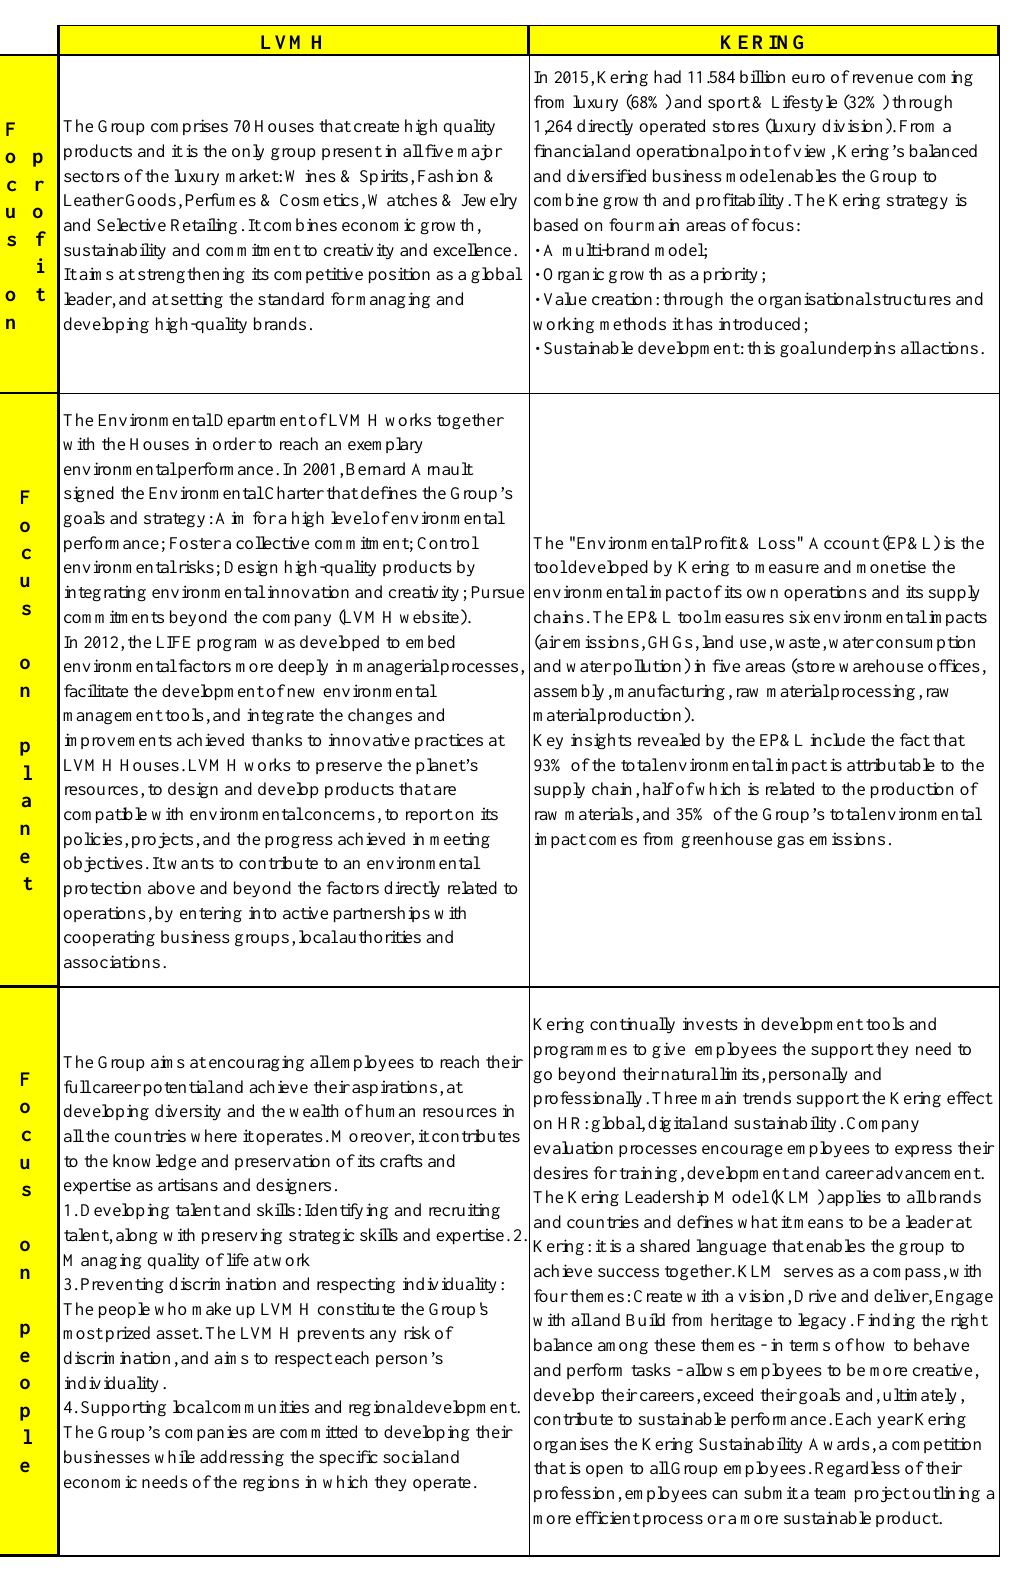
Table 3: Focus on profit, planet and people at LVMH and Kering LVMH